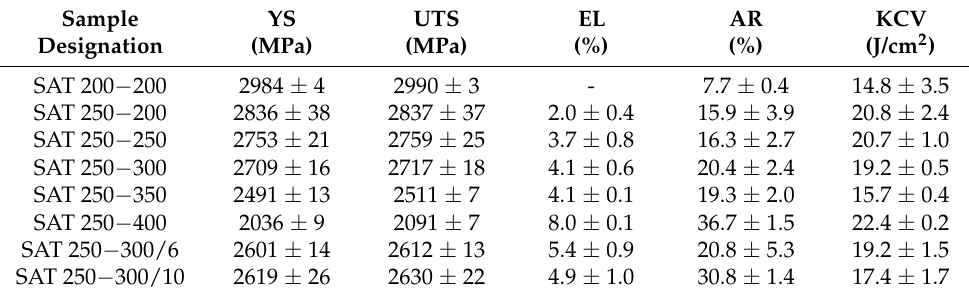
Table 5. Results of tensile testing, quenching and strain-assisted tempering (SAT).